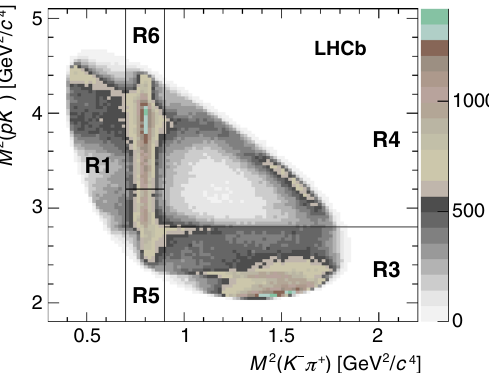
Region Definition R0